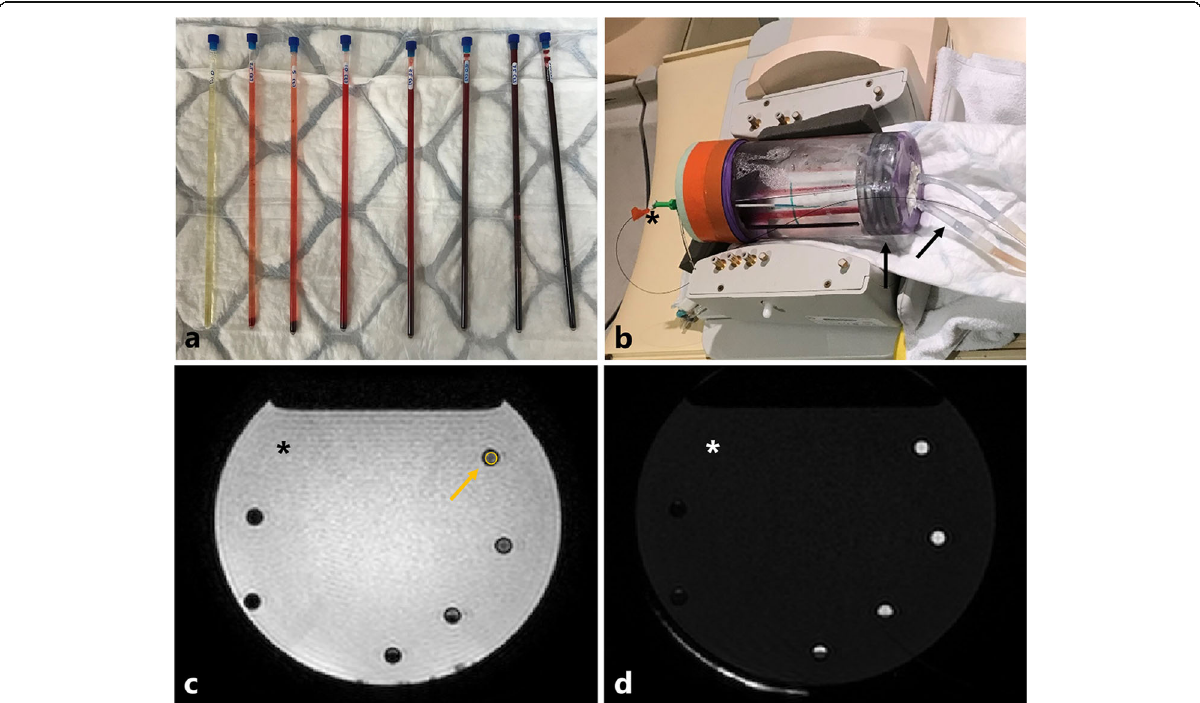
Fig. 1 a Nuclear magnetic resonance tubes with different ratios of synovial fluid and blood. Blood percentage from left to right: 0%, 2.5%, 5%, 10%, 25%, 50%, 75%, and 100%. b Phantom setup: a cylindrical water-filled holder with six samples, horizontally placed in a 16-channel knee coil using a 3-T MRI system. The phantom was equipped with a fiberoptic thermometer (the asterisk in all images) and a heating system based on heat exchange between water in the heating system (black arrows) and the water or oil volume in the phantom. c Scan image from the T1 mapping sequence. For each tube, a region of interest was manually placed within the tube region (example in yellow). d Scan image from the T2 mapping